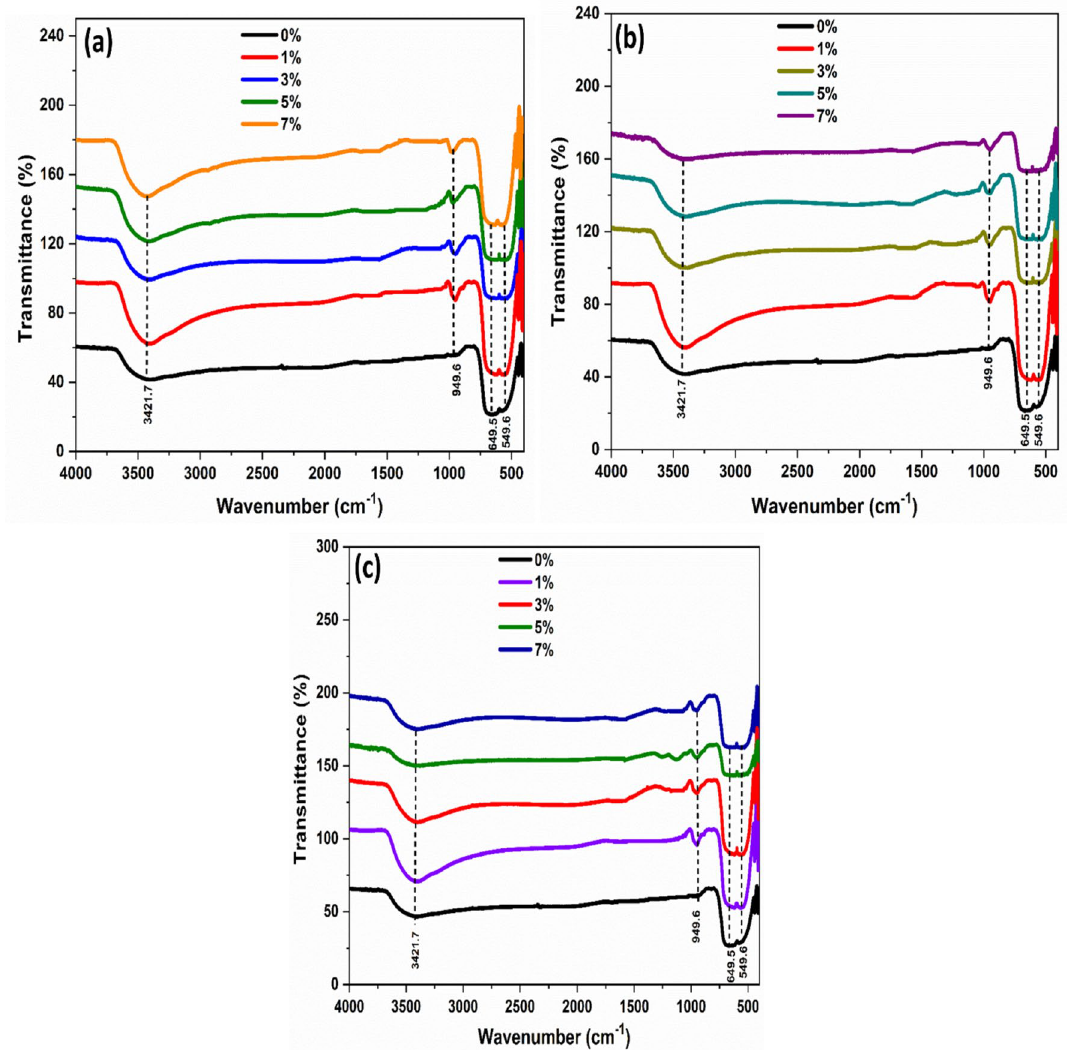
Figure 10. FT-IR spectra of Pure MgO metal oxide and transition metal MgO nanoparticles doped with: ( a ) Ni, ( b ) Co and ( c ) Fe with the different